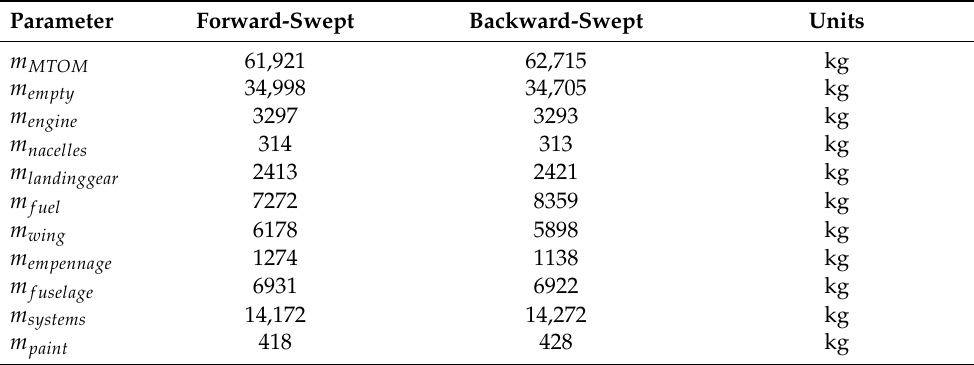
Table 6. Final masses summary of two configurations. Fuel mass is specified for the maximum payload scenario.